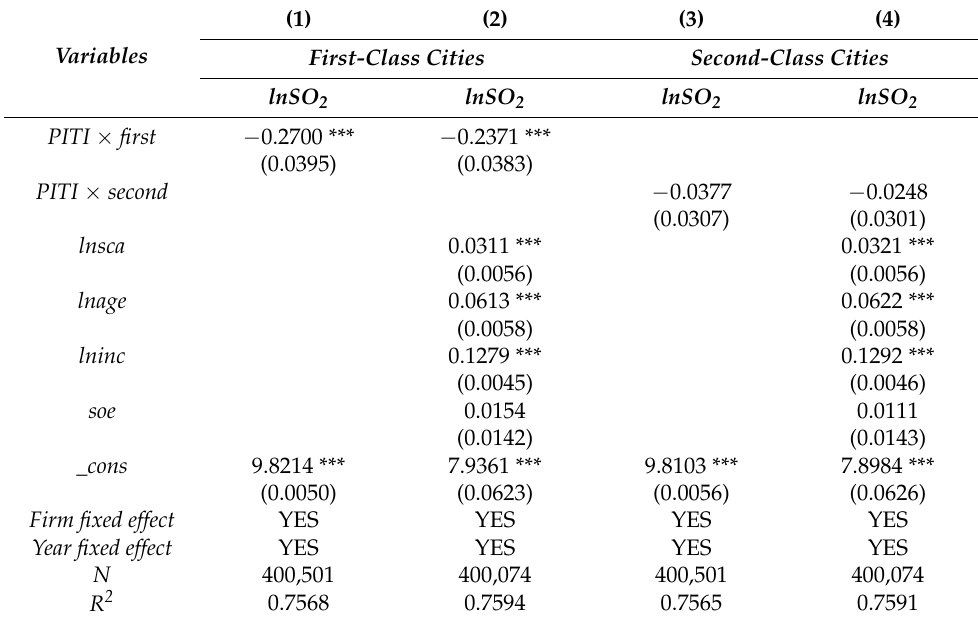
Table 7. The test of urban hierarchy